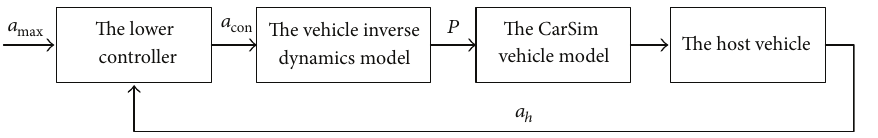
Figure 5: Scheme of the braking controller for emergency.